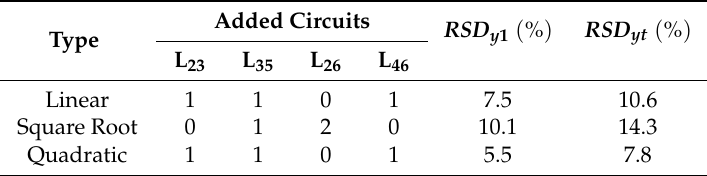
Figure 10. Various shapes of RSD curves. Table 4. Results for various RSD curves.